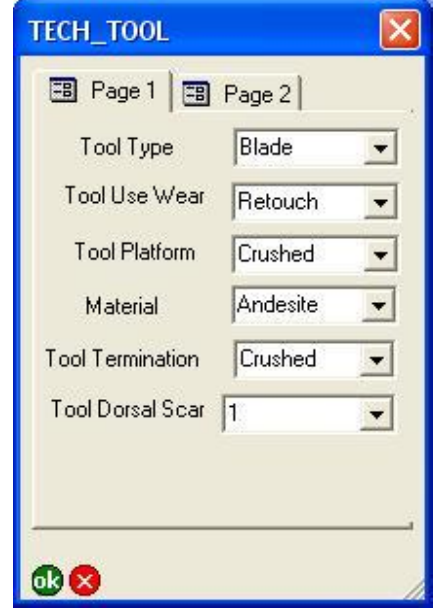
Figure 4 Form to interpret the artefact identified with technology tool